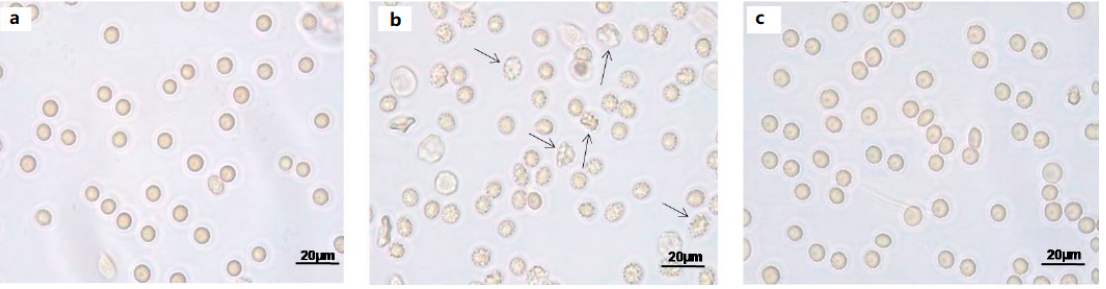
Figure 2. Light microscope observations of untreated (ctr) ( a ), 1 µ M Mel- ( b ) and 100 µ M Mel-treated erythrocytes ( c ), at 60 min of Mel incubation. Note the significant morphological changes in b (arrows), where 97% altered cells were observed.